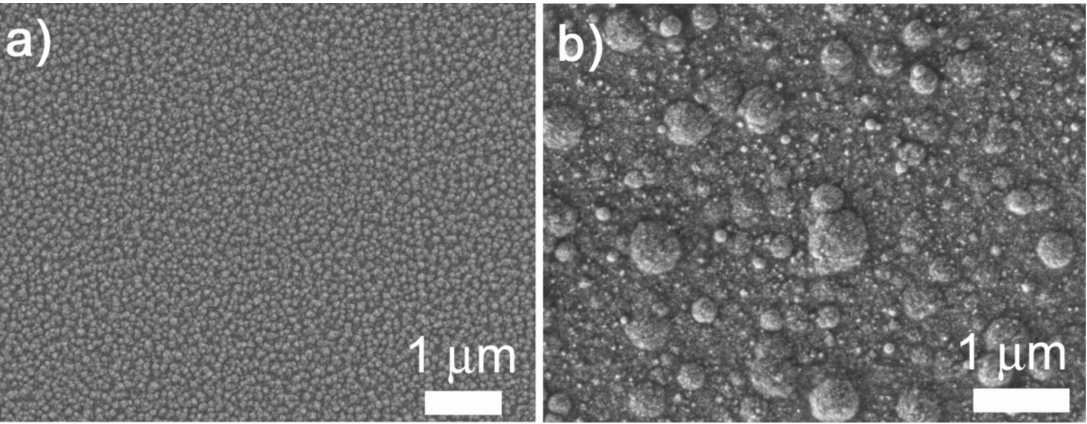
Figure 4. SEM images of CuNi films deposited from the same electrolyte composition at pH values of ( a ) 3 and ( b ) 2.